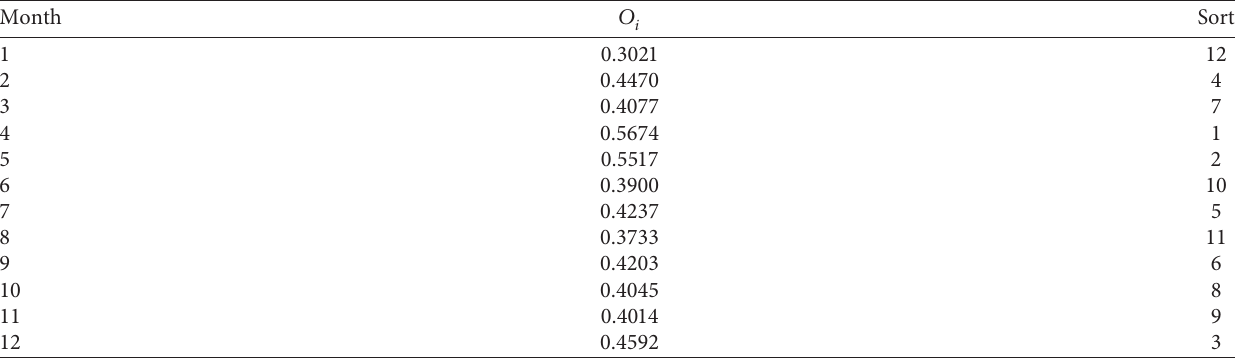
Table 4: The relative proximity degree of the integrated collection and distribution system of Tongchuan Railway Depot in each month